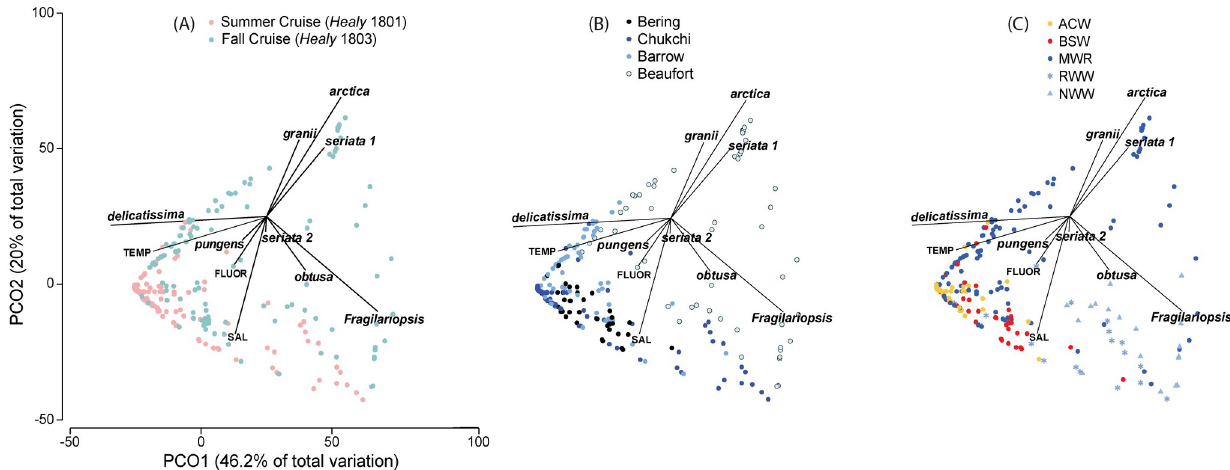
Fig 5. Biplots resulting from the PCO analysis. For both cruises (summer Healy 1801 and fall Healy 1803) combined (representing 17 taxa, 286 samples), the projection of samples (symbols) according to (a) cruise, (b) subregion, and (c) water masses is shown. Analysis performed in the taxa space (vectors) with environmental variables (vectors) independently calculated and overlaid on the biplot (TEMP = temperature, FLUOR = fluorescence, SAL = salinity). Only taxa for which identification has been validated by sequencing were included, Pseudo-nitzschia showing only the specific epithet for sake of simplicity.